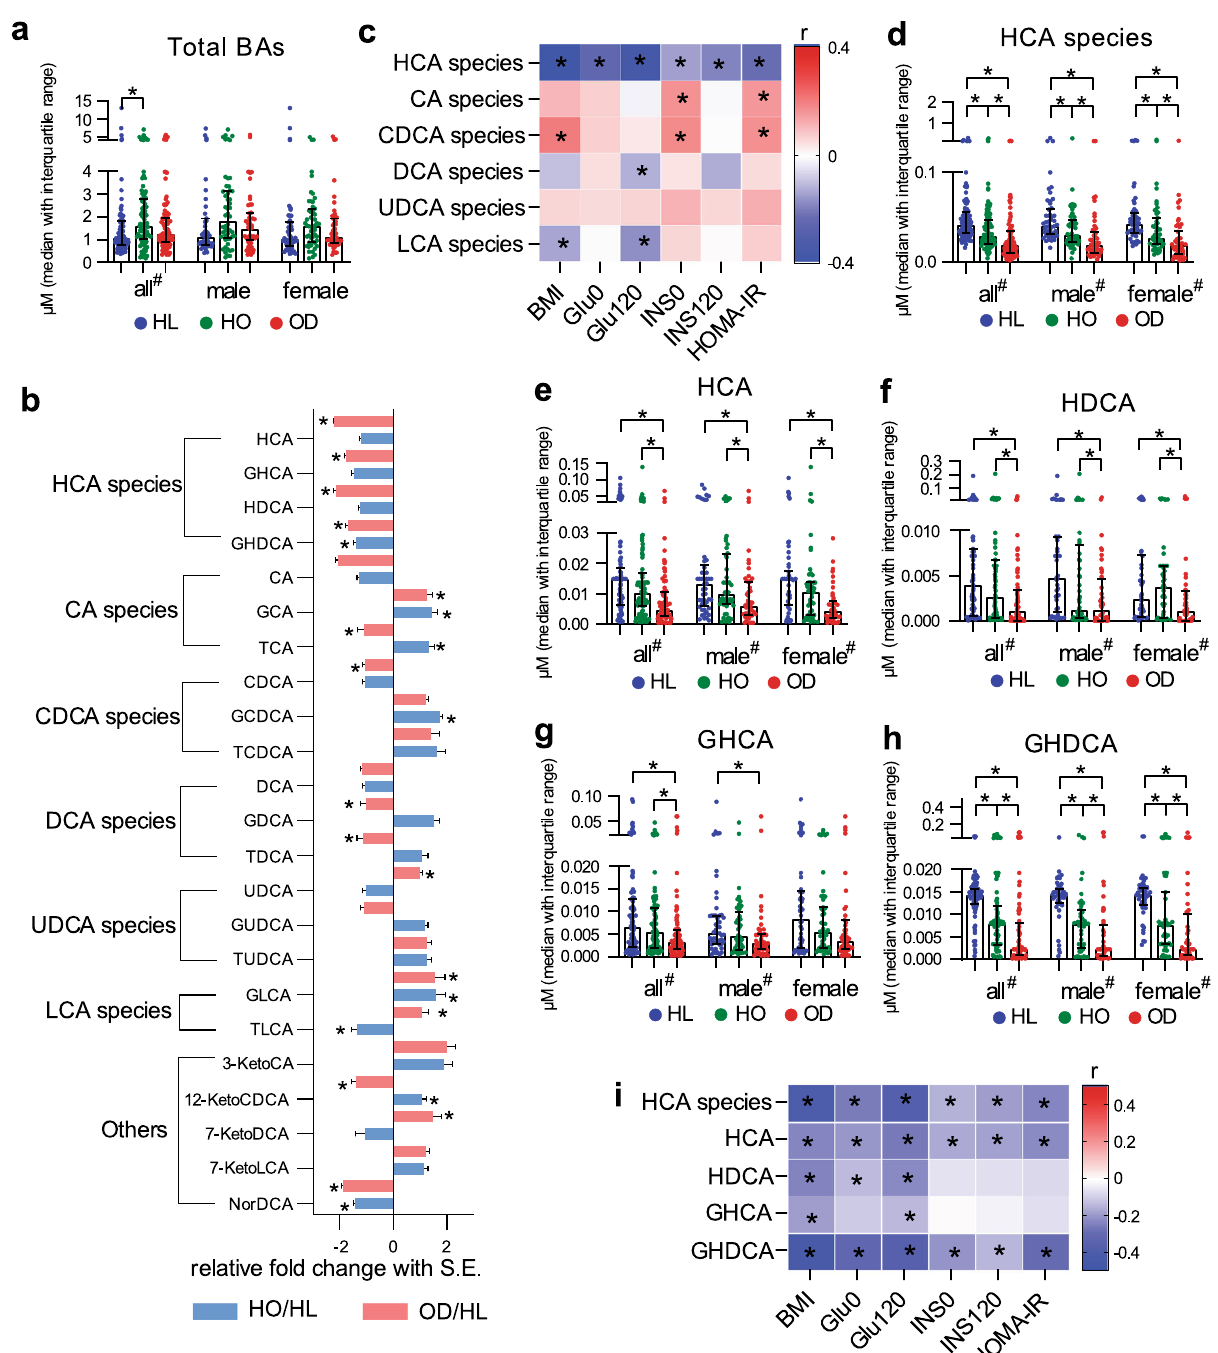
Fig. 1 Performances of HCA species and other BA species in the fi rst cross-sectional study. The data were based on a matched cohort, including healthy lean (HL, n = 103), healthy overweight/obese (HO, n = 103) and overweight/obese with T2DM (OD, n = 103) groups. a Total BAs based on all (male and female, n = 309), male ( n = 153) and female ( n = 156) samples. b Fold changes of 23 BAs in HO and OD groups relative to the mean values of HL group. c Heatmaps of Spearman correlation coef fi cients of 6 BA species with representative metabolic markers. d – h Group differences of total and individual HCA species. i Heatmaps of Spearman correlation coef fi cients of total and individual HCA species with representative metabolic markers. Data are expressed as median with interquartile range ( a , d – h ), and mean with SE ( b ). In the bar plots ( a , b , d – h ), * and # indicate the statistical signi fi cance ( p < 0.05) between two groups and among three groups, respectively, based on two-sided Kruskal – Wallis test. In the heatmaps ( c , i ), r value indicates Spearman correlation coef fi cient, and * indicates the statistical signi fi cance ( p < 0.05) based on Spearman